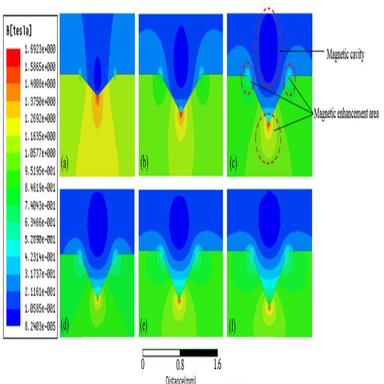
Simulation results of different triangular defect depths for HMM; (a) Triangular defect depth of 0.1 mm; (b) Defect depth of 0.2 mm; (c) Defect depth of 0.3 mm; (d) Defect depth of 0.4 mm; (e) Defect depth of 0.5 mm; (f) Defect depth of 0.6 mm.